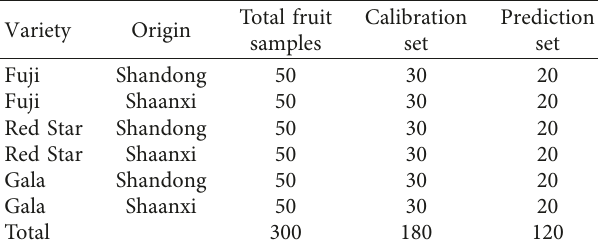
Table 1: Source of apple